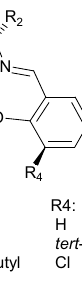
Figure 9. Structure of a metal‐salen complex [40].